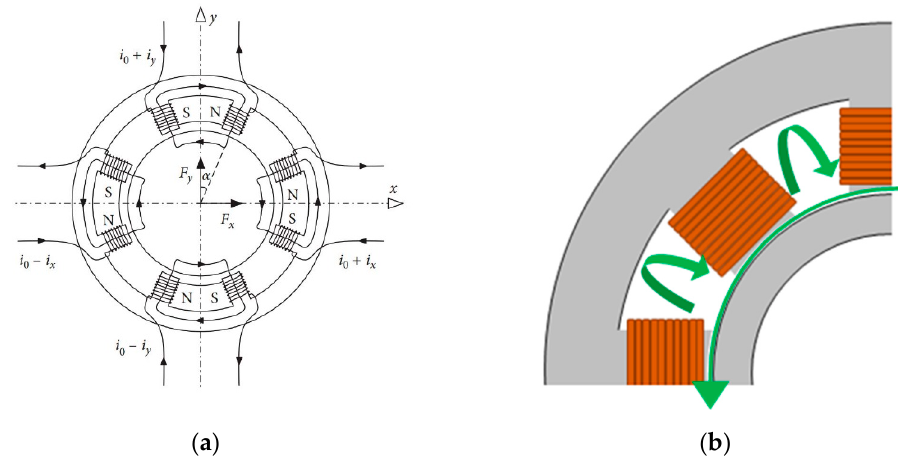
Figure 3. Cross section of a radial active-control magnetic bearing (AMB): ( a ) electromagnets in the magnetic bearing [17]; ( b ) possible secondary flow between the electromagnets.